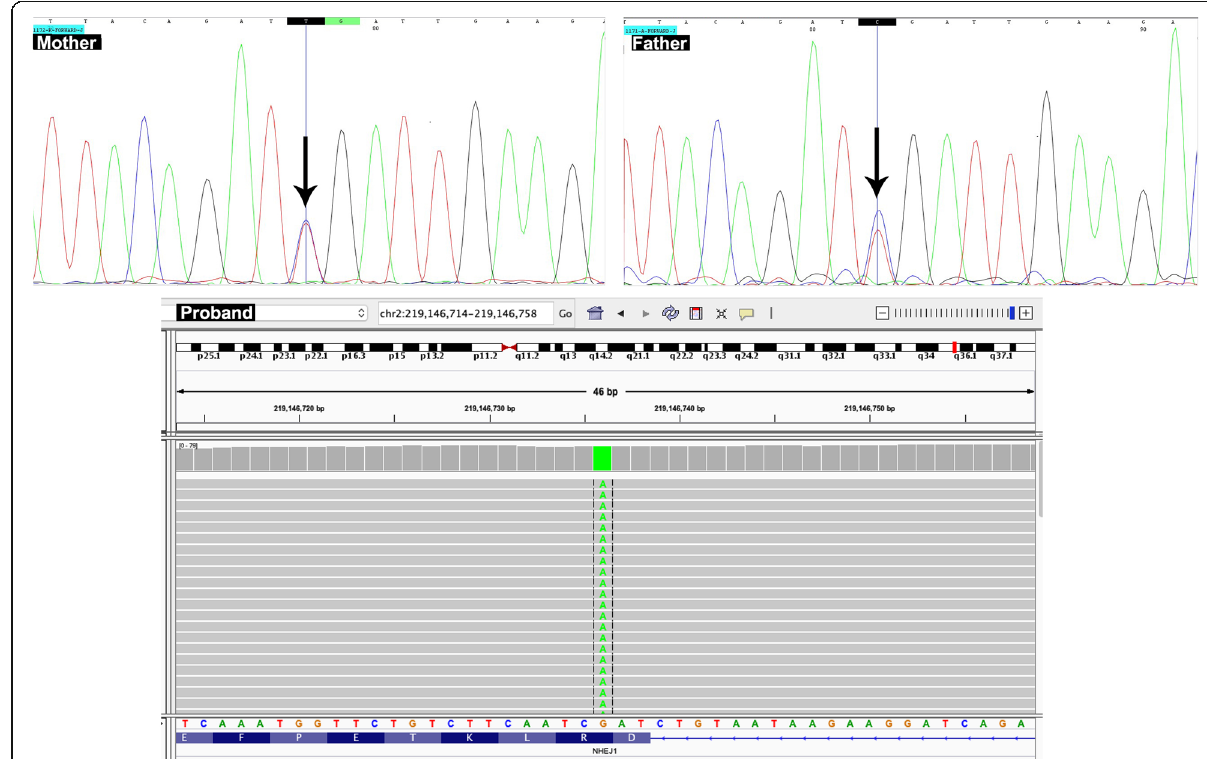
Fig. 1 WES results showing homozygous mutation in NHEJ1 gene in the proband, as visualized using Integrative Genome Viewer (IGV). Sanger sequencing confirms the presence of heterozygous mutation in NHEJ1 gene in both parents. Arrows indicate the site of the